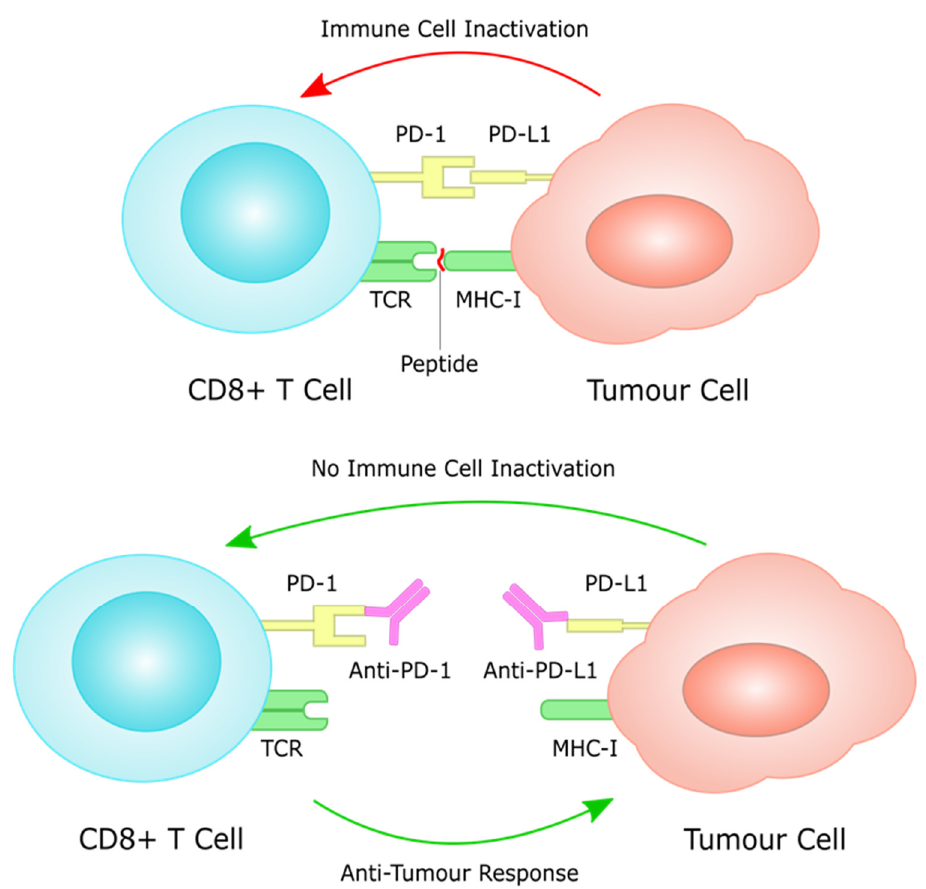
Figure 3. PD-L1 on tumour cells works through the PD-1 receptor on T cells to induce immune cell inactivation. Treatment with immune checkpoint inhibitors inhibits this interaction, often through monoclonal antibodies against PD-1 and PD-L1, restoring immune cell function against tumour cells.